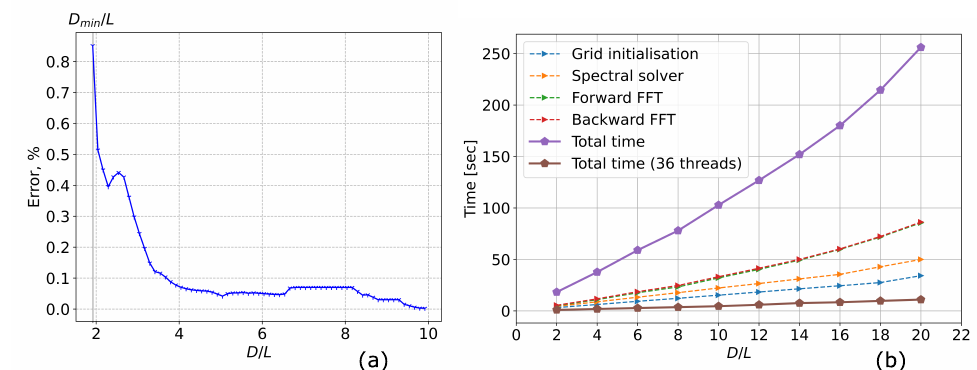
Figure 4. ( a ) Relative error of the peak amplitude, comparing the computations in a subregion to that in the full domain, as a function of D , the subregion size. Here f-number = 0.3. ( b ) Computational time of one iteration of the method (grid initialisation, forward FFT, spectral solver execution, and backward FFT), as a function of the parameter D / L . All the simulations were performed using Hi-Chi. Computation time of sequential (all lines except the brown one) and multithreaded (brown line, 36 physical cores) versions of the code are presented. Size of the computational grid varies with the parameter D and is equal to ( 56 D / L ) × 896 ×